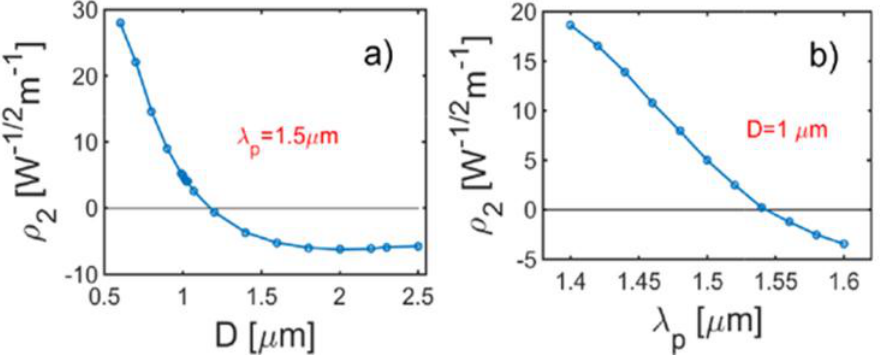
Figure 3. Detuning  between the second harmonic and pump modes as functions of pump wavelength  p , fiber diameter D and waveguide width W : ( a ) Fixed  p = 1.5  m. ( b ) Fixed D = 1  m. ( c ) Fixed W = 495 nm. Dashed line indicates the phase matching condition  = 0. Broadband phase-matching is expected in the conditions marked by blue circles.